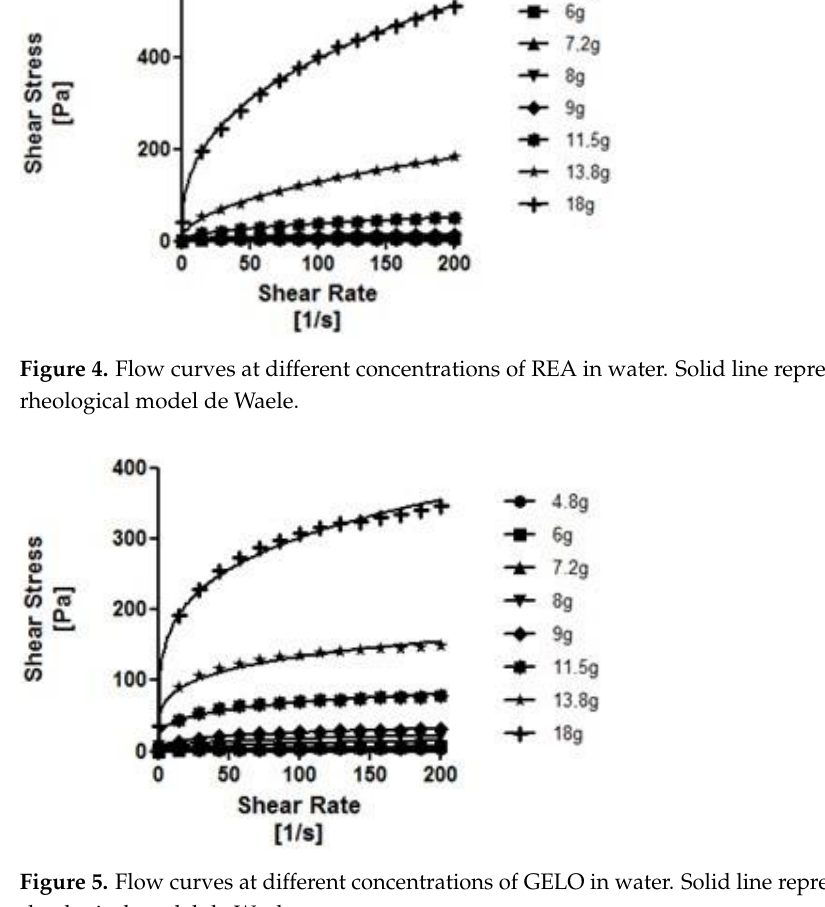
Figure 5. Flow curves at different concentrations of GELO in water. Solid line represents the Ostwald rheological model de Waele.